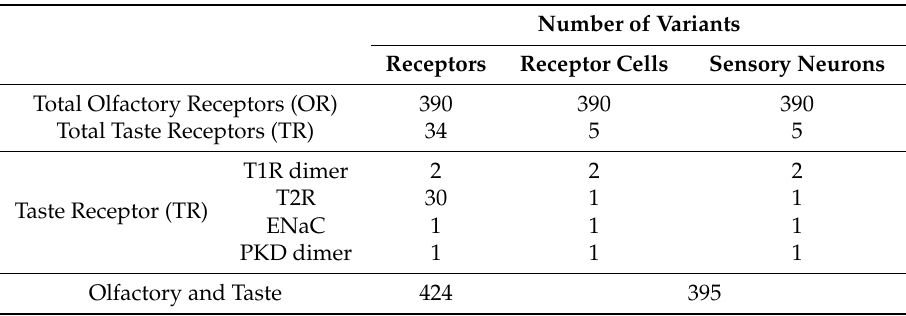
Table 1. Chemosensory receptors with distinct